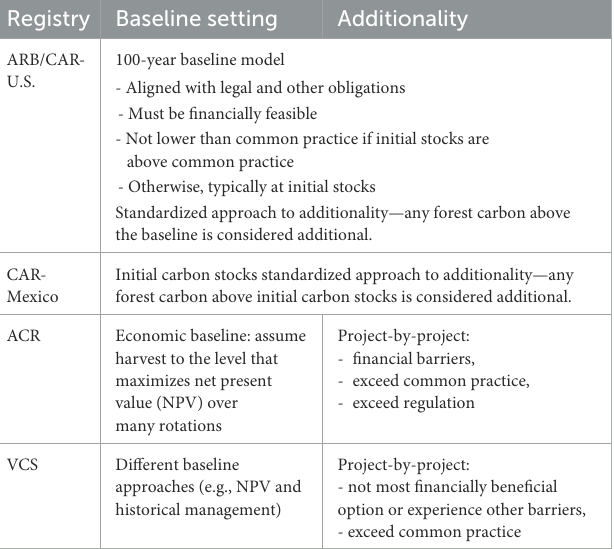
TABLE 2 Overview of how IFM protocols treat baselines and additionality.